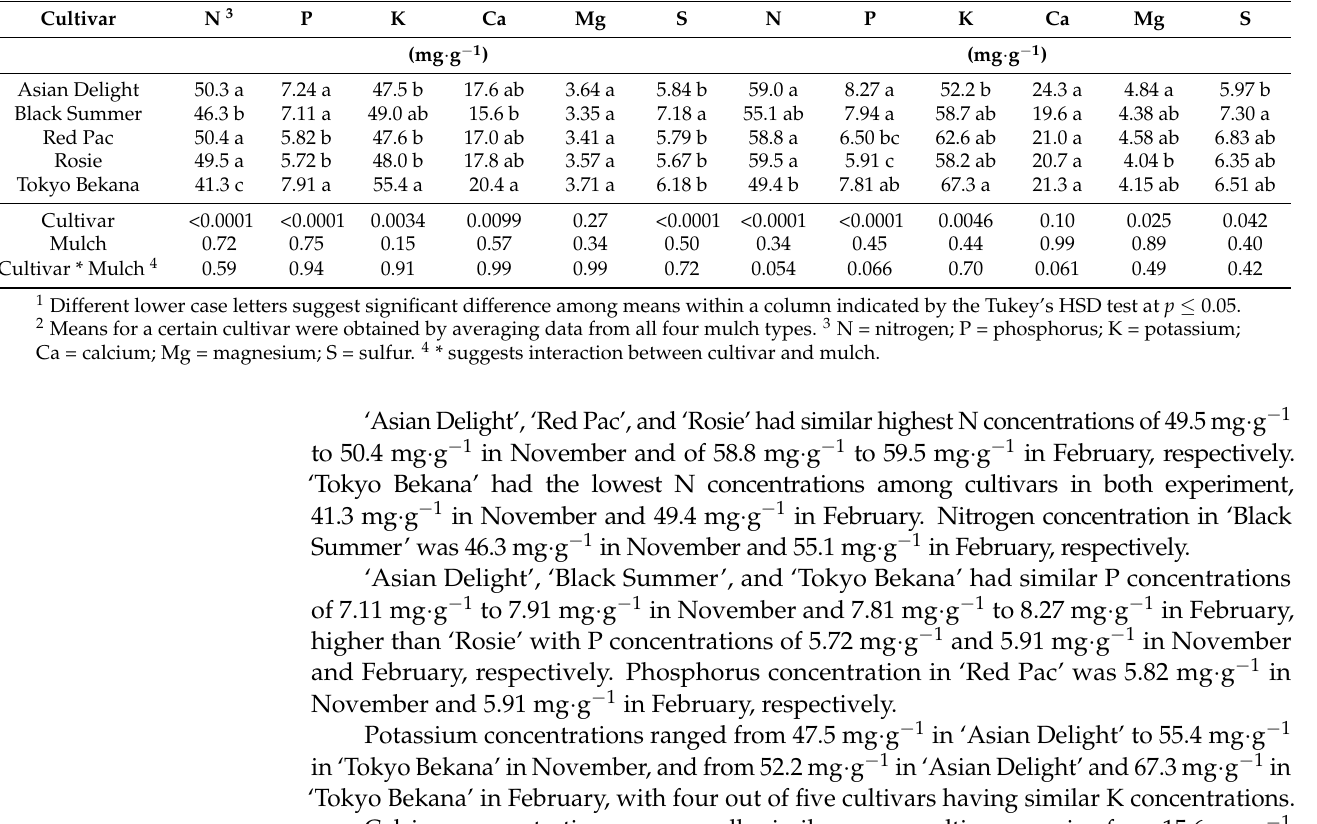
Table 6. Macronutrient concentrations in five Asian green cultivars grown with four types of mulches in a high tunnel in Starkville, MS in two experiments.